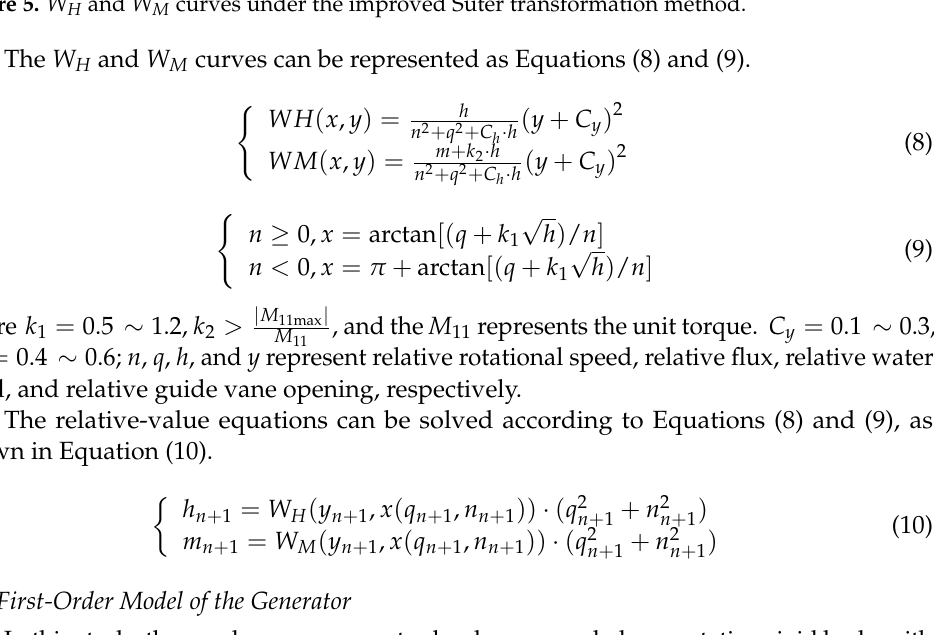
flux, relative water head, and relative guide vane opening, respectively. The relative-value equations can be solved according to Equations (8) and (9), as shown in Equation (10).